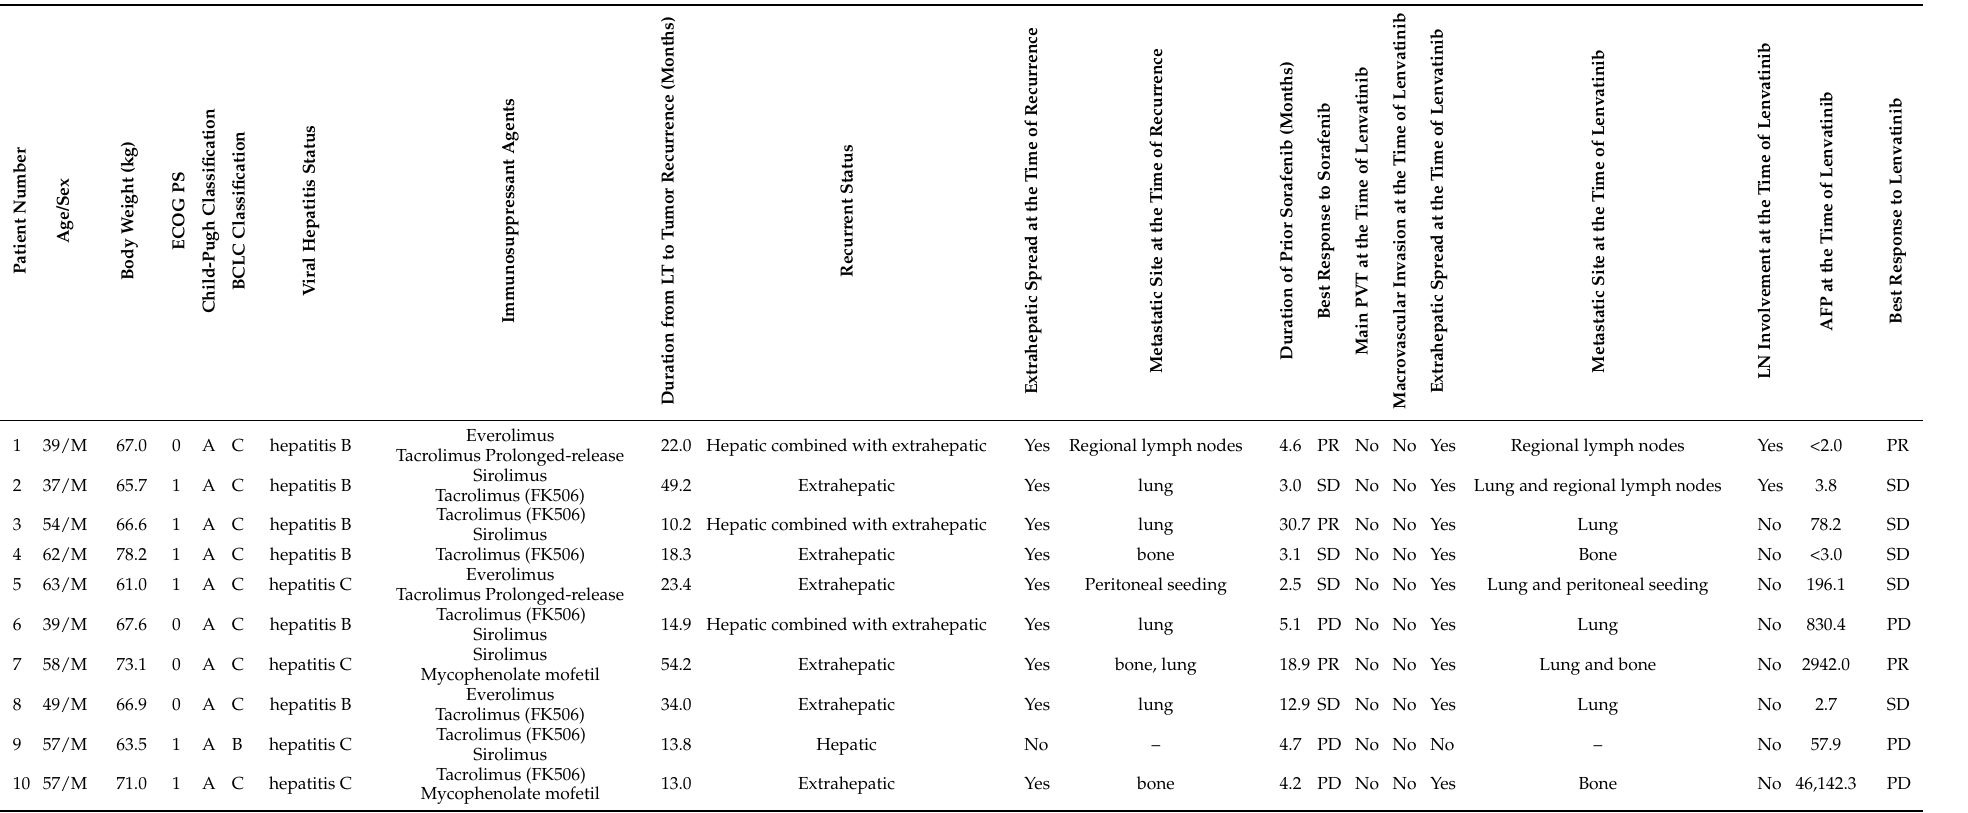
Table 1. Characteristics of 10 patients with recurrent unresectable hepatocellular carcinoma after liver